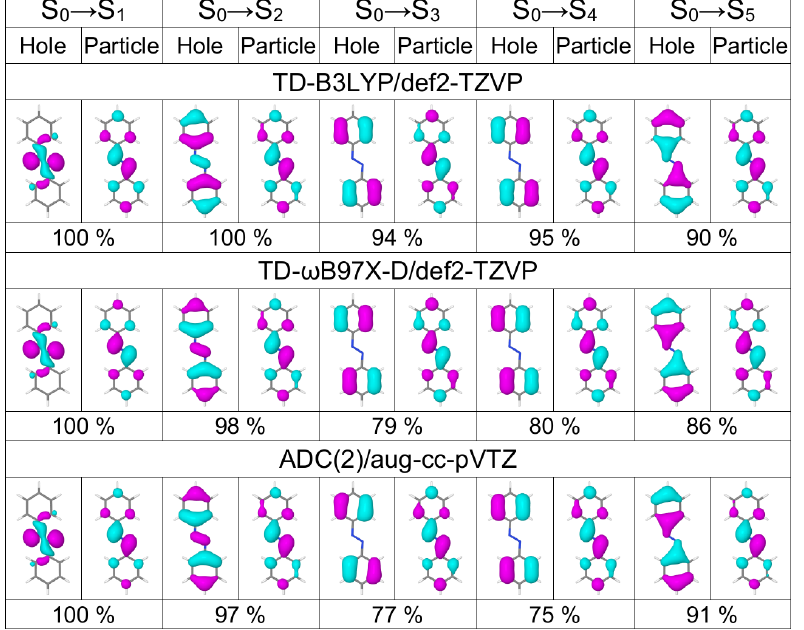
Figure 1. Dominant natural transiion orbital pairs for the lowest five transitions of the azobenezene monomer calculated at the TD-B3LYP/def2-TZVP ( top row ), TD- ω B97X-D/def2-TZVP ( middle row ), and ADC(2)/aug-cc-pVTZ ( bottom row ) levels of theory. Percentage shows the contribution of a given hole–particle pair to a transition. The monomer geometry is optimized at the B3LYP/def2- TZVP